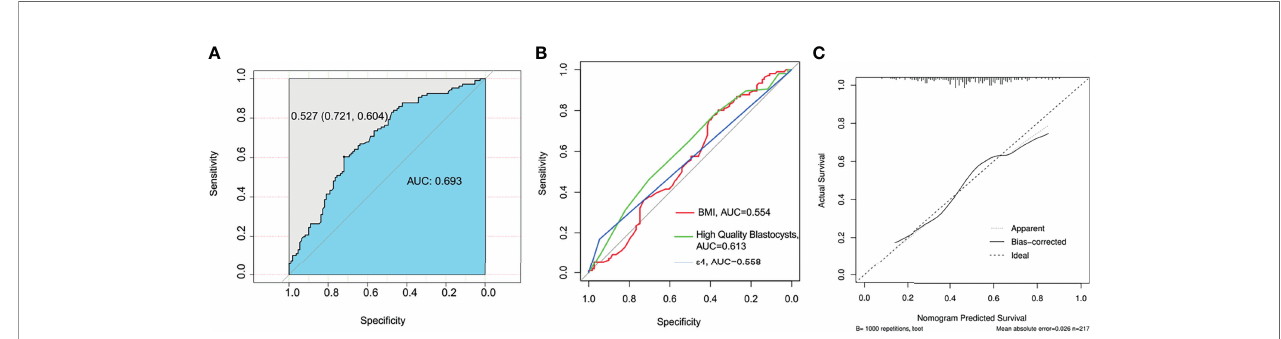
FIGURE 3 | ROC curve of the prediction model and nomogram for patients suffering from EMT. The AUC value should be in the range of 0.5 to 1.0. An AUC of 0.5 corresponds to a random prediction, and the criterion 0.5 < AUC < 1 indicates that the model has predictive signi fi cance. (A) Multifactor sensitivity for predictingpatients with EMT; AUC=0.693. (B) Sensitivity to each of the following three factors for predicting patients with EMT: BMI, AUC=0.554; high-quality blastocysts, AUC=0.613; and ApoE- e 4, AUC=0.558. (C) A nomogram was drawn to assess the agreement between the predicted results and the observed actual results. The dashed lines represent the predicted results, and the solid lines represent the actual results. The close fi t between the predicted results and the actual results indicates that the prediction effect could be considered good; mean absolute error = 0.026; n